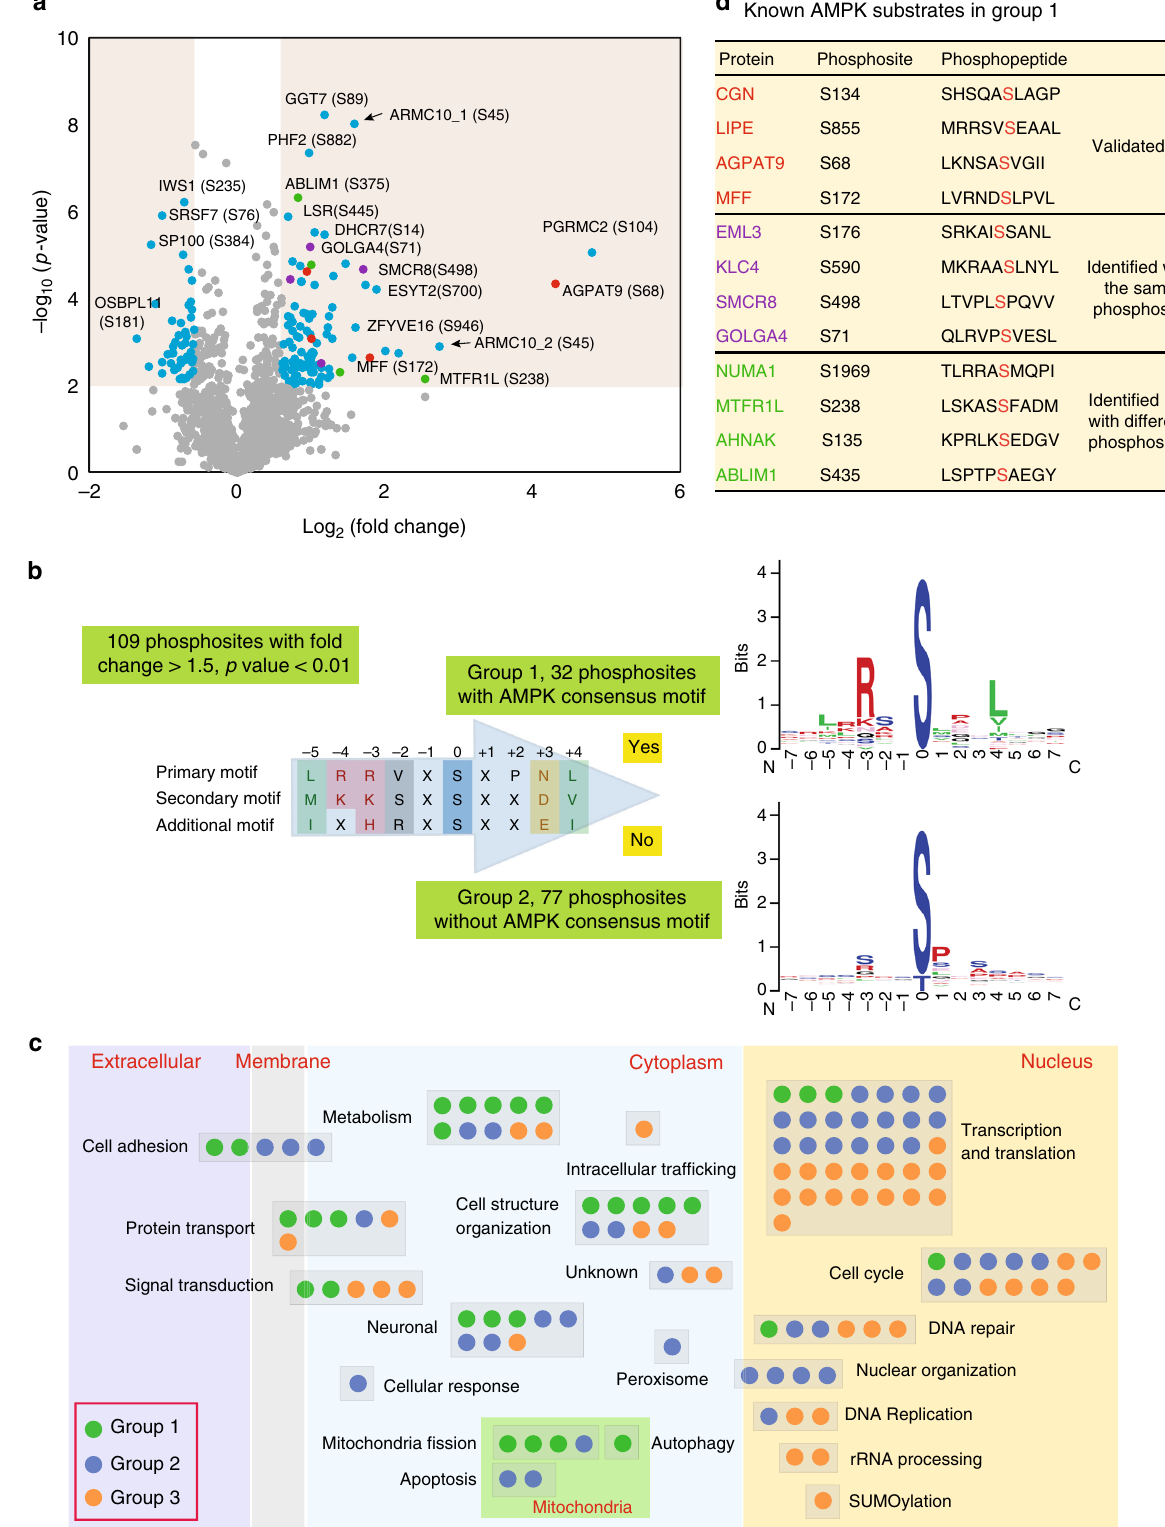
AMPK substrate. The phosphosites in group 1 ( n = 32) (Supplementary Figure 2a) had peptide sequences similar to the conserved AMPK substrate motif 20 and may be sites directly phosphorylated by AMPK. The phosphosites that were upregu- lated in WT cells but did not meet these rules and did not have